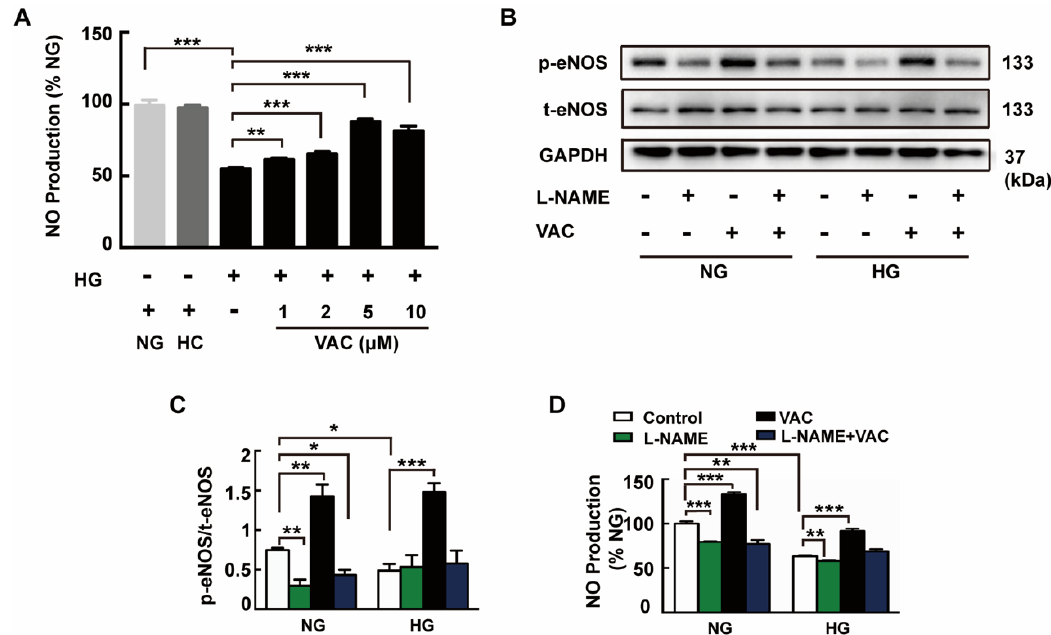
Figure 2. VAC promotes eNOS phosphorylation in high glucose (HG)-exposed human microvascular endothelial cell-1 (HMEC-1) cells. The HMEC-1 cells pre-incubated with vaccarin (5 µ M) for 12 h or eNOS inhibitor L-NAME (100 µ M) for 1 h prior to 30 mM HG exposure. ( A ) Nitric oxide (NO) generation was determined with ELISA. n = 5 for each group; ( B, C ) Representative blots showing protein expressions of p-eNOS in HMEC-1 cells. Bar groups showing the quantification of p-eNOS / t-eNOS, n = 3 for each group; ( D ) NO generation. n = 5 for each group. Values are mean ± SEM. * p < 0.05, ** p < 0.01, *** p < 0.001. NG, normal control group; HC, hyperosmotic control group;